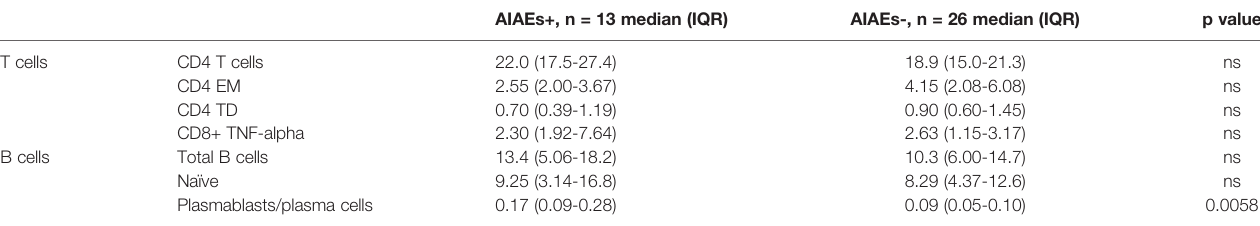
TABLE 5 | Percentages of cell subsets one year after fi rst cycle of treatment in patients with secondary autoimmunity who had associations with baseline subsets. AIAEs+, n = 13 median (IQR) AIAEs-, n = 26 median (IQR) p value T cells